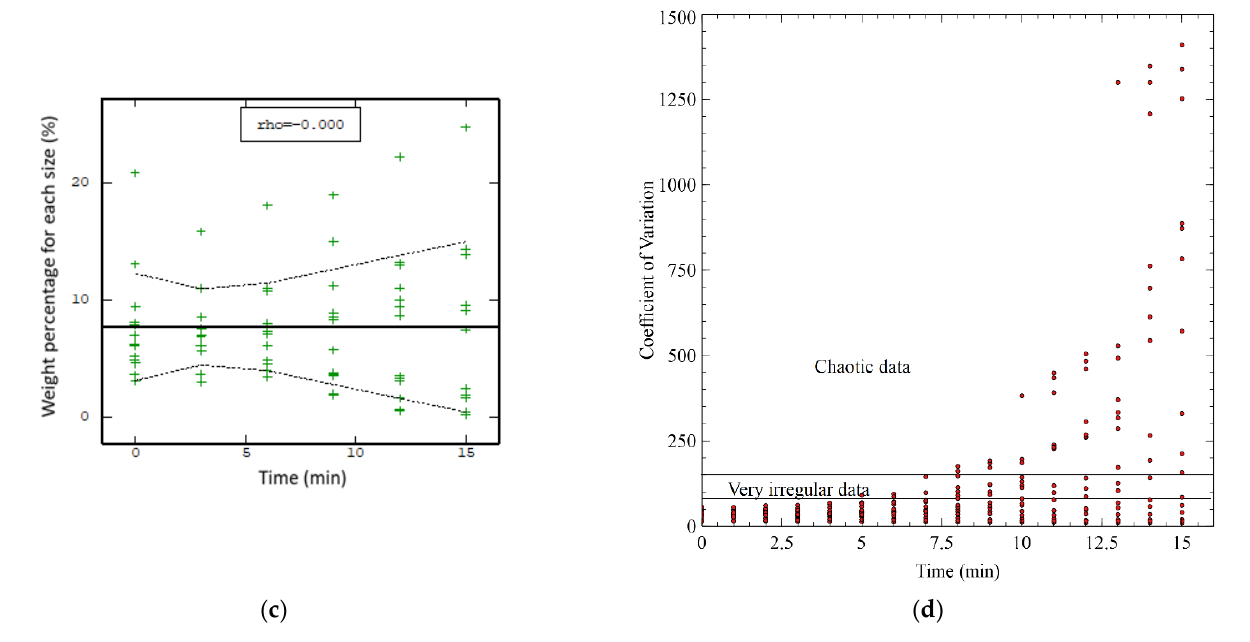
Figure A10. Results for LGP-3 for the time evolutions. ( a ) Weight of each sizer fluctuation zone of the reconstructed data for ore -A; ( b ) 𝐶𝑣 for ore – A. ( c ) Weight of each sizer fluctuation zone of the reconstructed data for ore -B; ( d ) 𝐶𝑣 for ore – b.